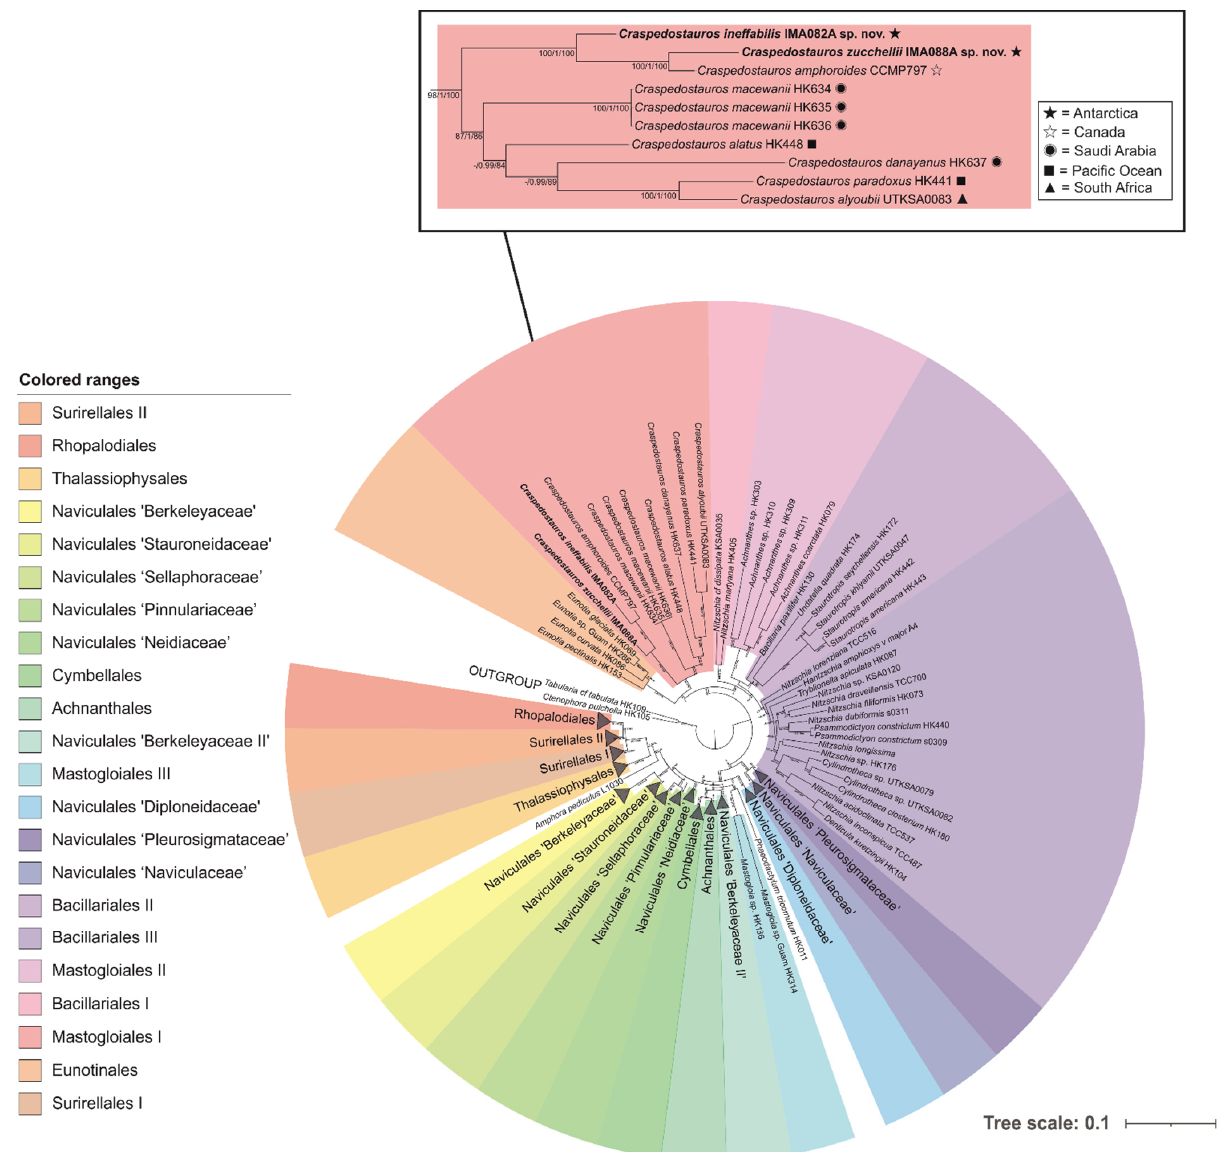
Figure 2. Maximum likelihood (ML) phylogeny of the concatenated 18S rDNA, rbc L and psb C regions alignment with members of the genus Craspedostauros . Approximate likelihood ratio tests based on Shimodaira–Hasegawa-like procedures (SH-aLRT) values (%), Bayesian posterior probabilities (PP) and ML bootstrap values (%) are shown above branches (SH-aLRT supports ≥ 80%, posterior probabilities ≥ 0.70 and bootstrap values ≥ 50%).